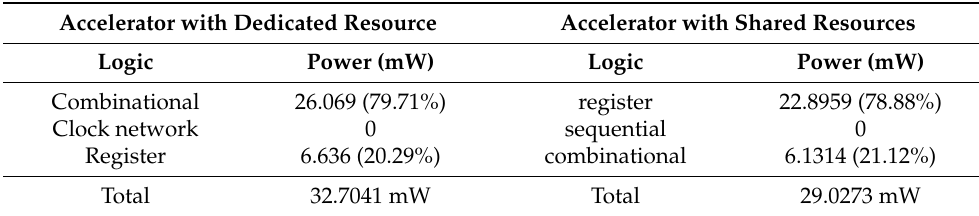
Table 3. Comparison in terms of power for dedicated vs. shared resources architectures. Accelerator with Dedicated Resource